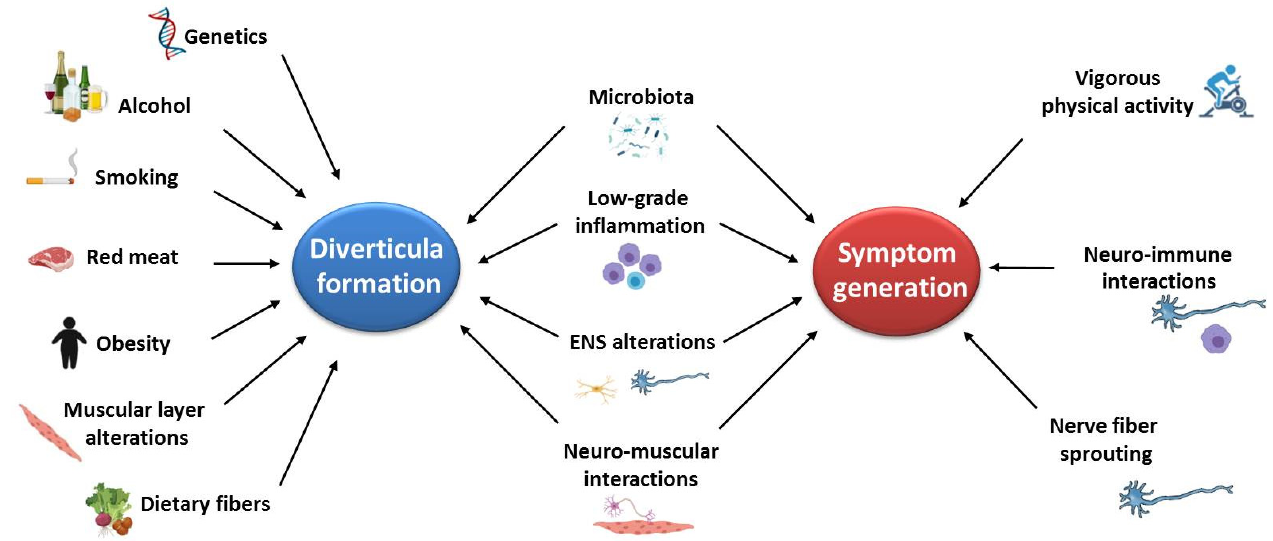
Figure 1. Factors involved in diverticula formation and/or in symptom generation. On the basis of the available data, the figure shows which factors are likely involved in diverticula formation (i.e., in the pathophysiology of diverticulosis and SUDD) and/or in symptom generation (i.e., in the pathophysiology of SUDD).